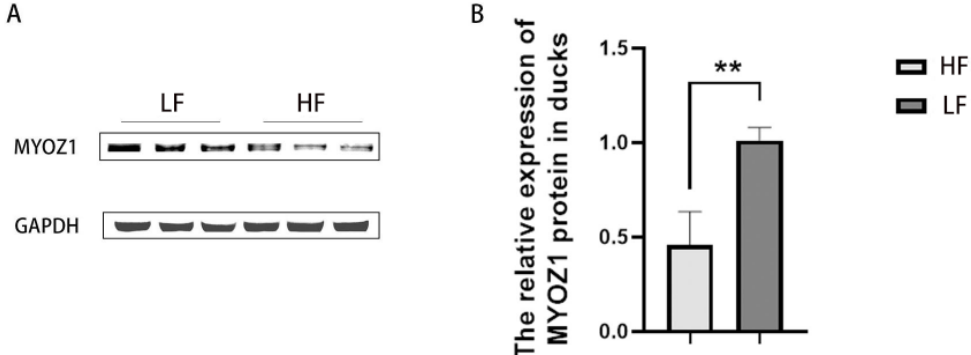
Figure 2. Expression of MYOZ1 and GAPDH proteins in meat ducks with high and low feed conversion ratios. ( A ) Typical map of Western blot. ( B ) Western blot gray value statistics. ** indicates that the difference is extremely significant ( p < 0.01).